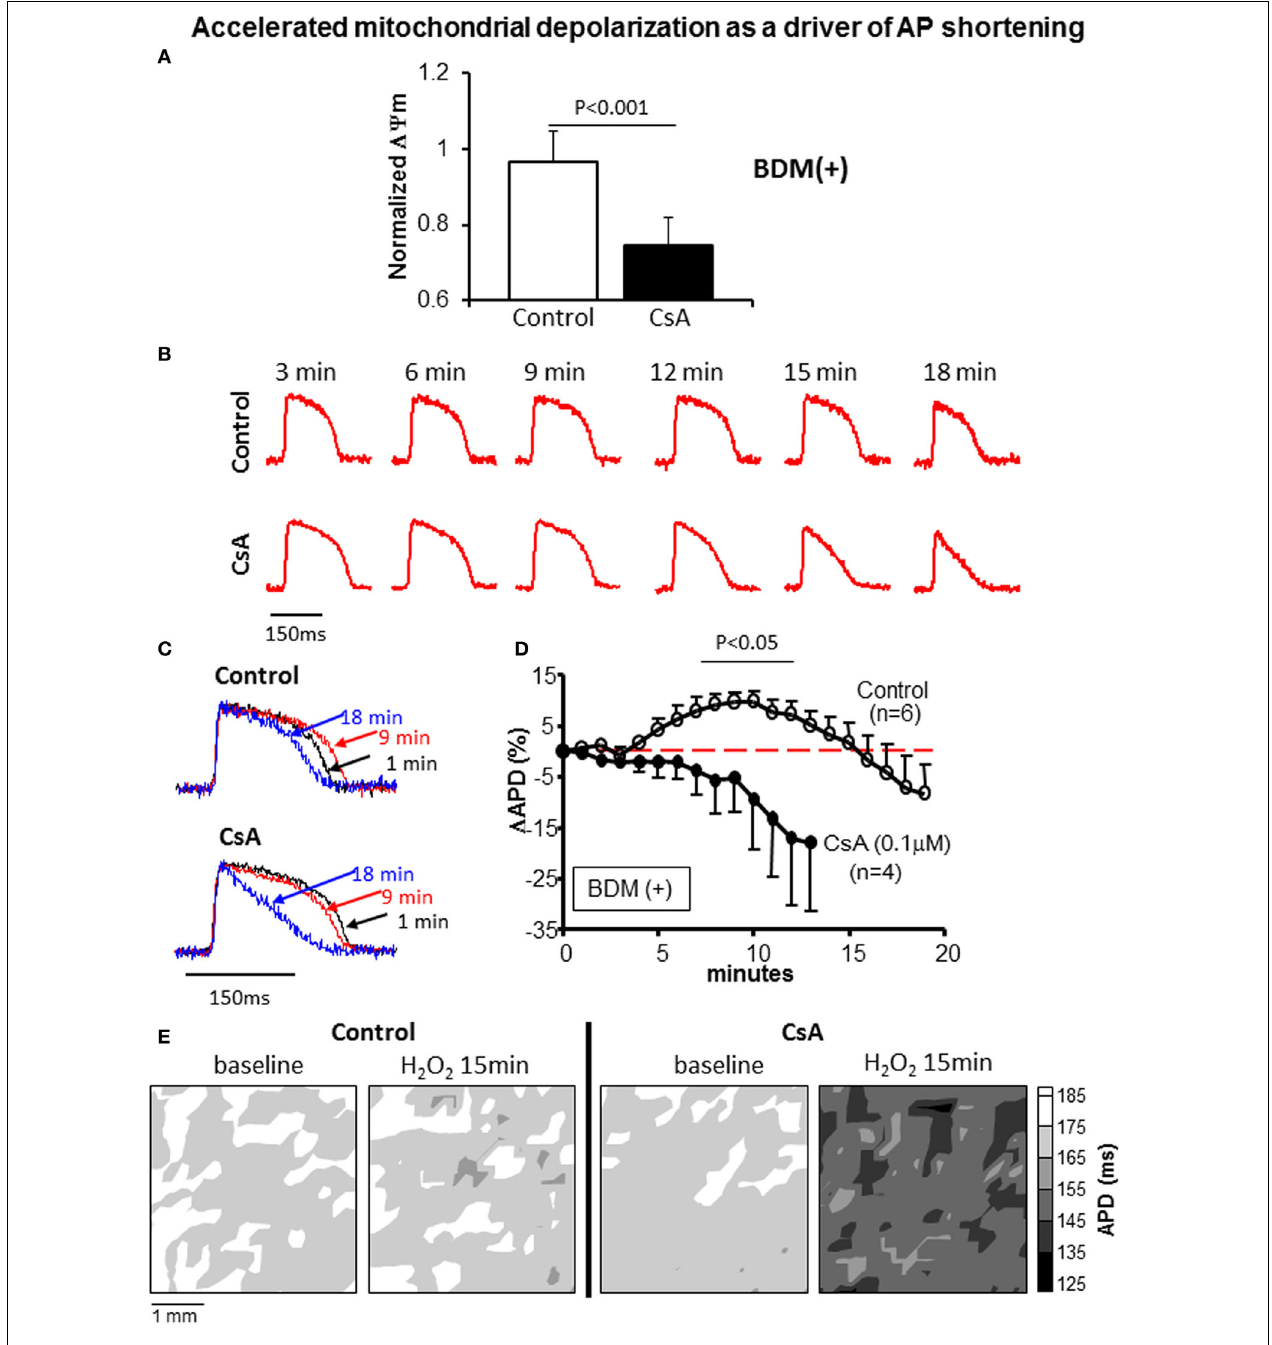
FIGURE 7 | (A) (cid:2)(cid:3) m at 15min of OS normalized to baseline value in control and CsA treated hearts. (B,C) Representative action potentials recorded during early challenge with acute OS in control and CsA treated hearts. AP shortening is more pronounced in CsA compared to control hearts, indicating